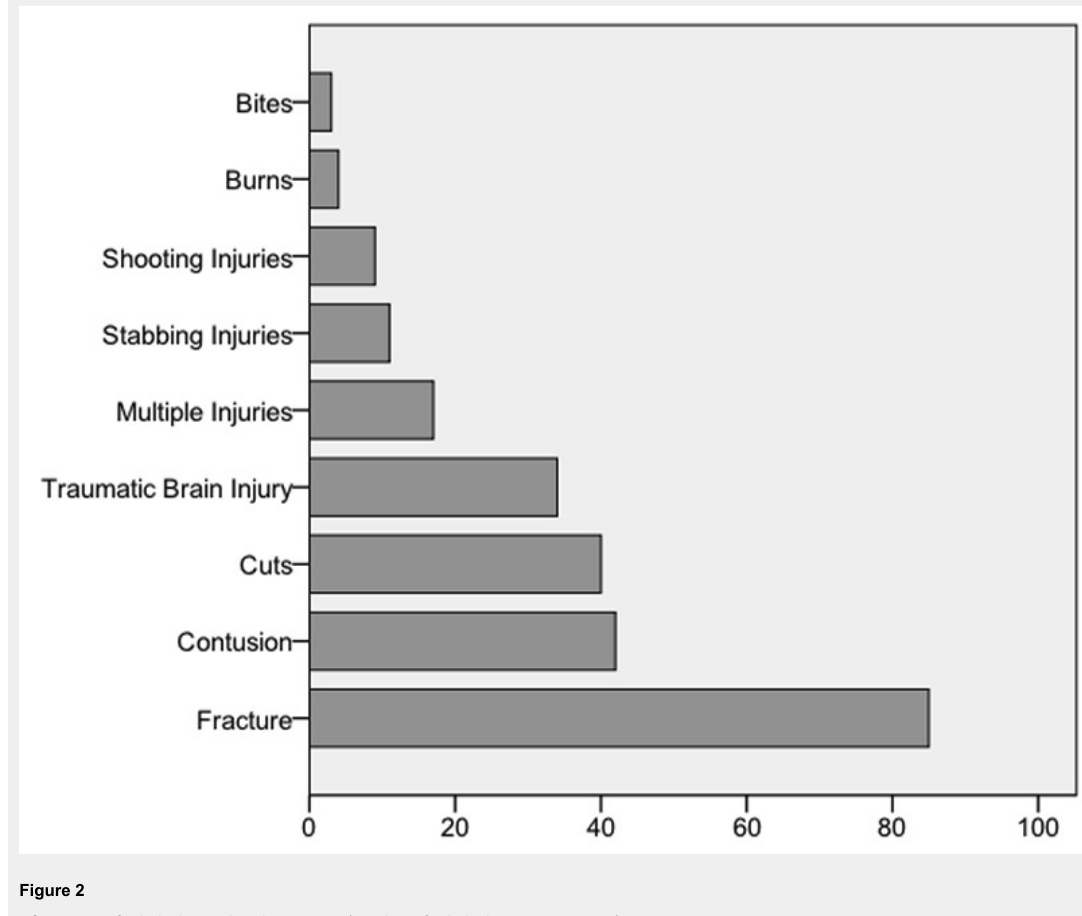
Figure 2 ■Summary of admissions related to trauma (number of admissions per